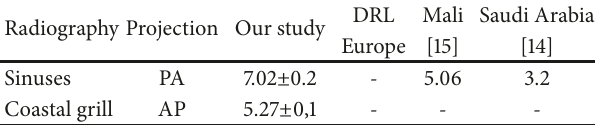
Table 4: Comparison between our values and some of